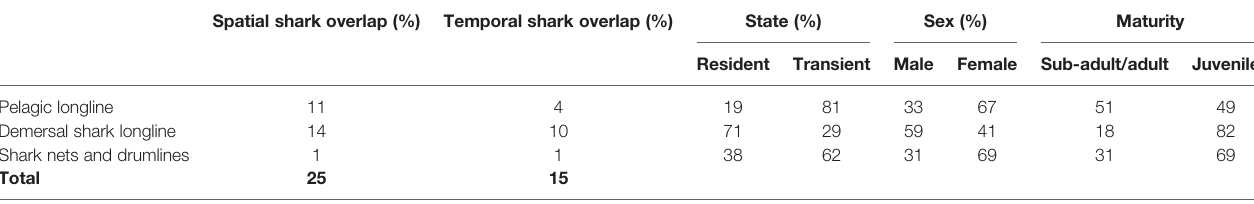
TABLE 2 | The spatial and temporal overlap between white sharks ( Carcharodon carcharias ) and longline and gillnet fi shing effort in the South African Exclusive Economic Zone. Spatial shark overlap (%) Temporal shark overlap